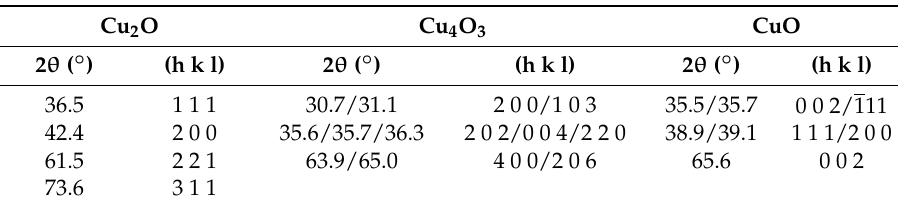
Table 1. The summary of diffraction peaks in XRD patterns.